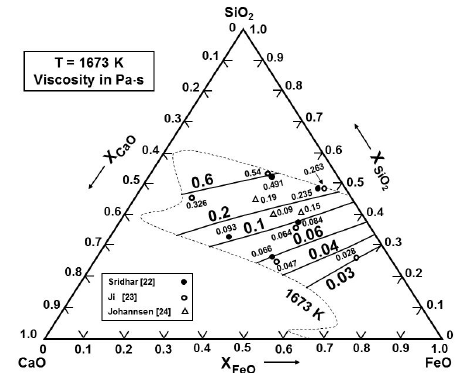
−CaO−FeO melts at 2